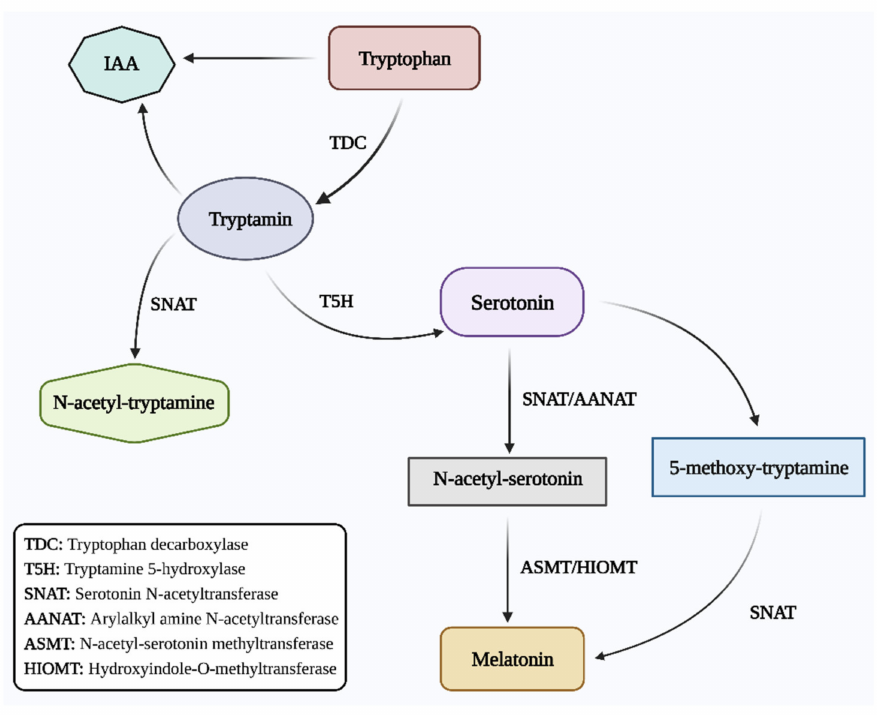
Figure 1. Schematic pathway of melatonin expression. This figure was created with BioRender.com (accessed on 15 September